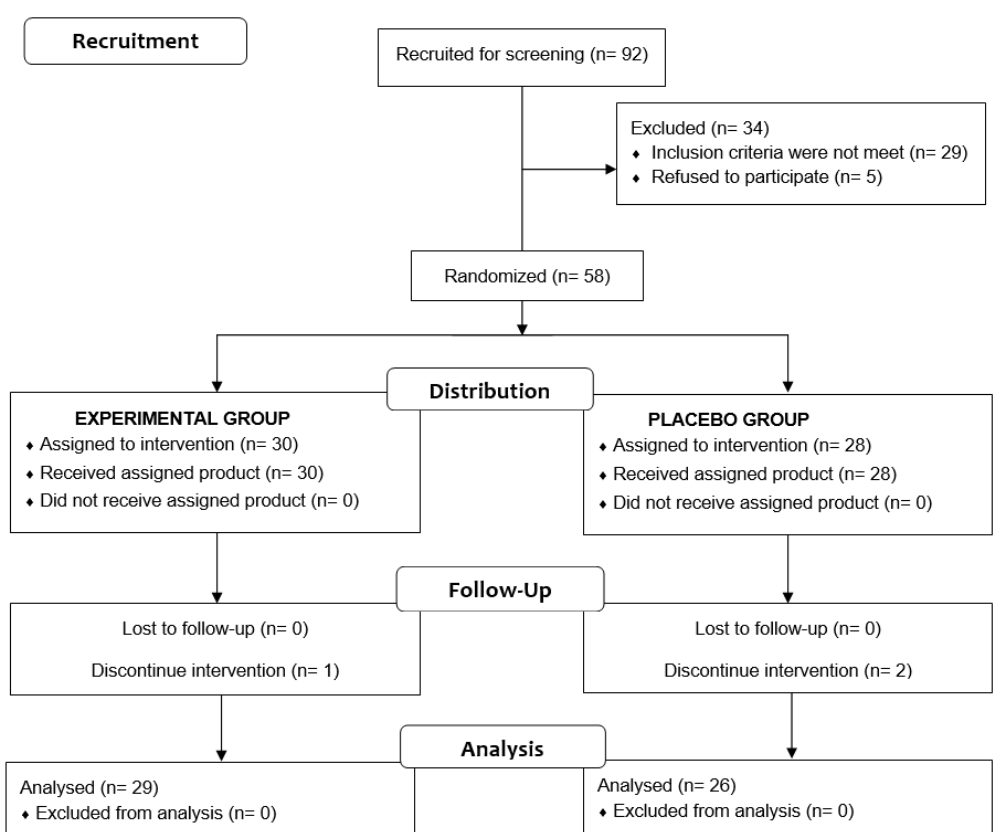
Figure 1. Flow chart of the study population.